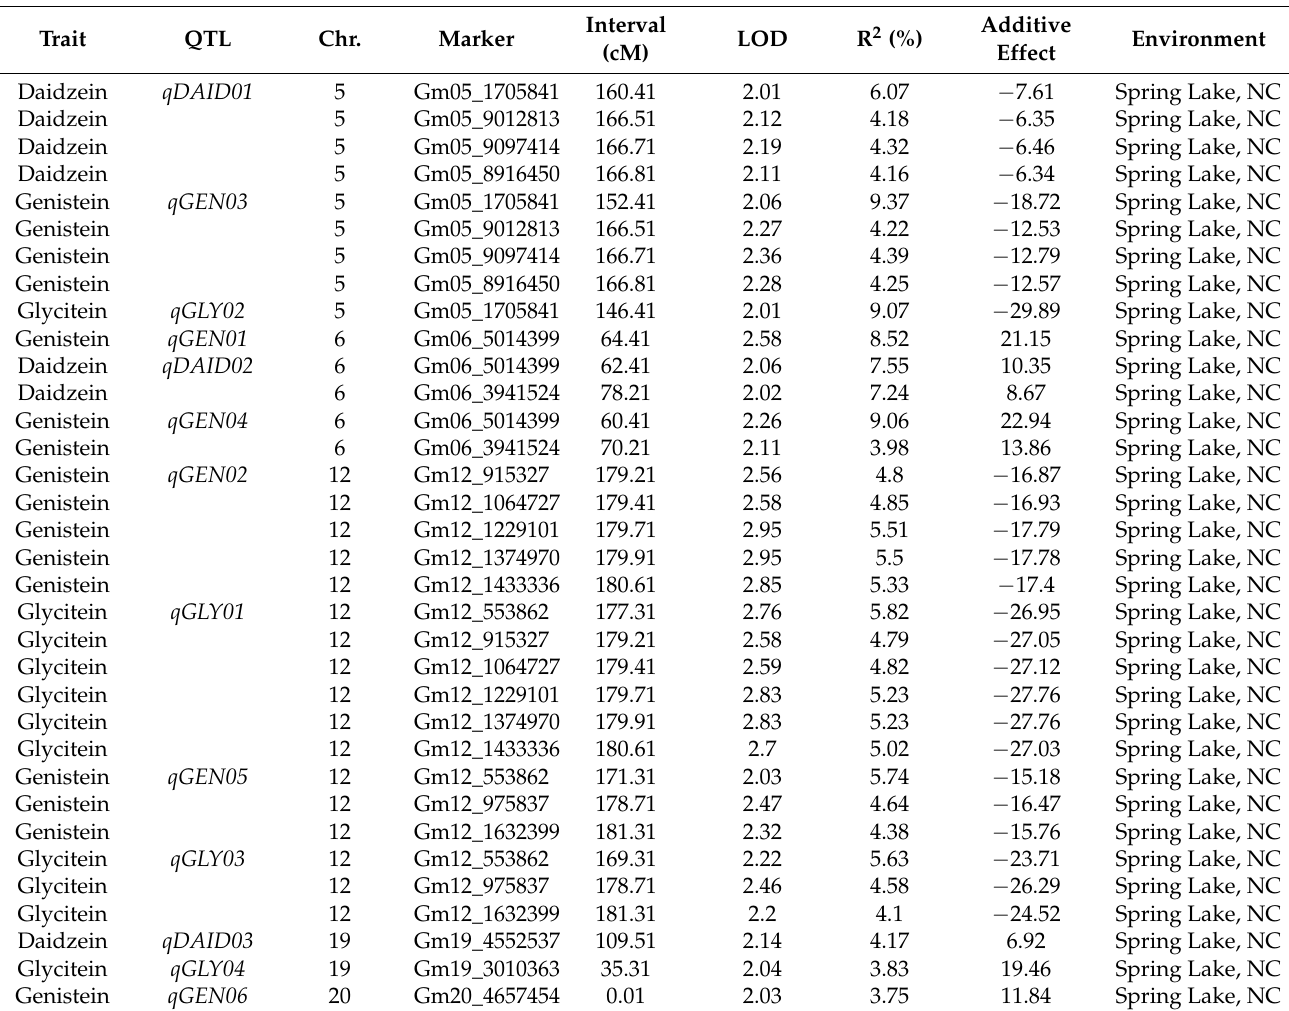
Table 4. QTL that control seed isoflavone (daidzein, genistein, and glycitein) contents in two environments over two years (2A. 2018 and 2B. 2020). The two environments are Spring Lake, NC (2018) (2A) and Carbondale, IL (2020) (2B). Only QTL with LOD scores > 2.0 and identified by composite interval mapping (CIM) method of QTL Cartographer (Wang et al., 2012) are